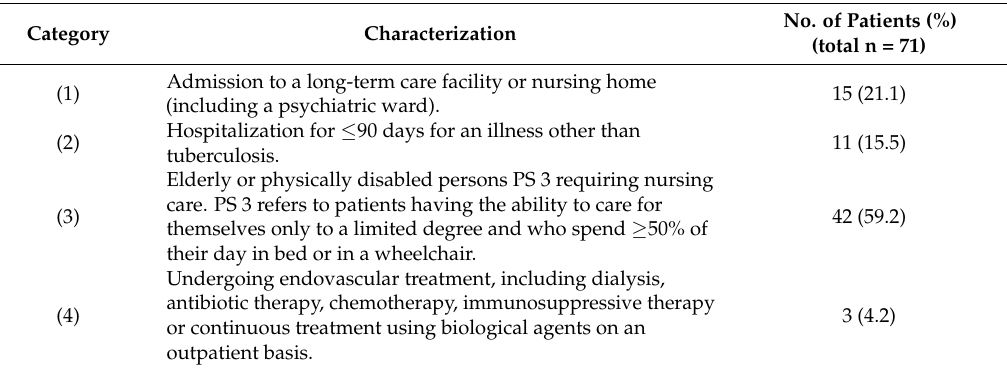
Table 1. Definition and characterization of patients with